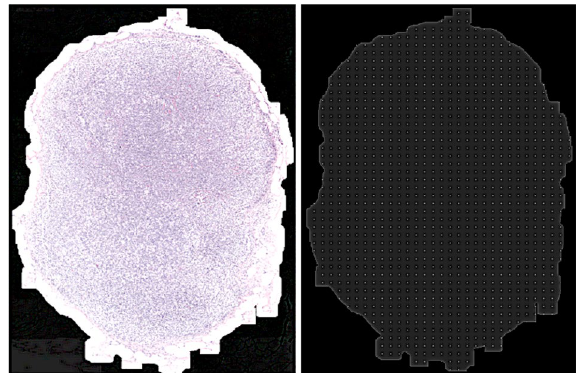
Figure 4. (Left to Right) An illustration of the tissue mask overlayed on a small region of the WSI image at low resolution (level-4), here the white region corresponds to the tissue mask; An illustration of the generated uniform patch coordinate sampling grid, here the points on the image act as centers from which high-resolution image patches were extracted from the WSI